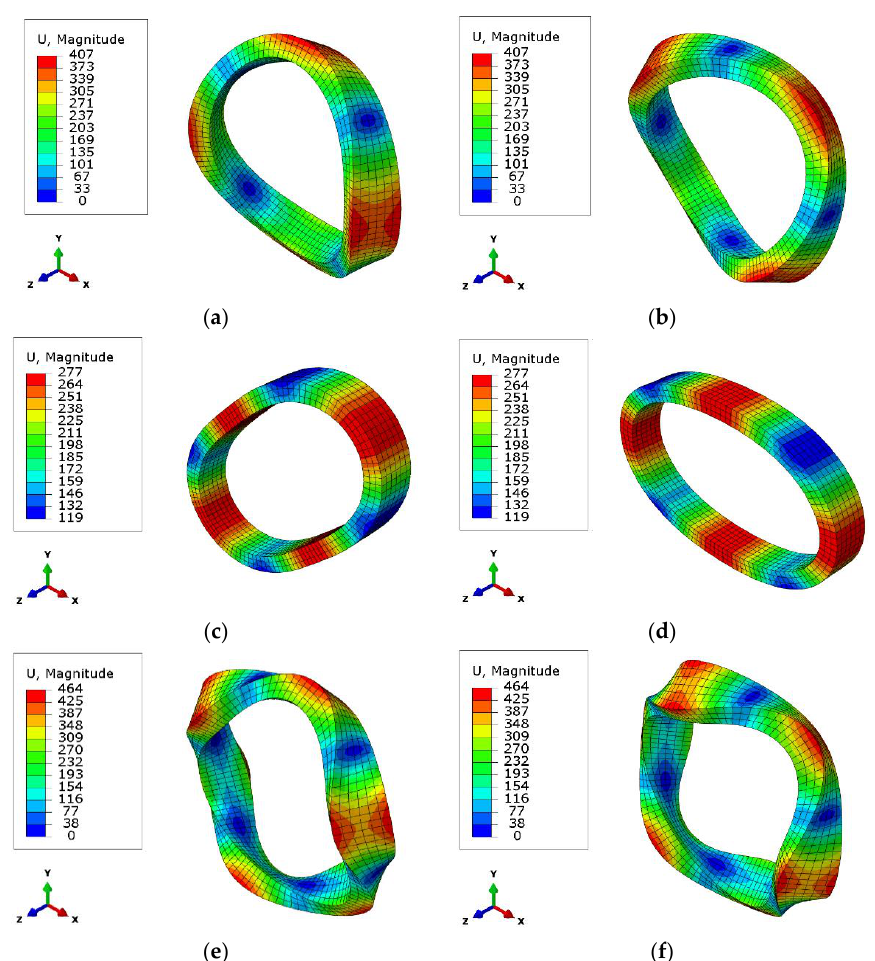
Figure 18. Mode shapes for the coil Type-1: ( a , b ) first mode shape; ( c , d ) second mode shape; ( e , f ) third mode shape.